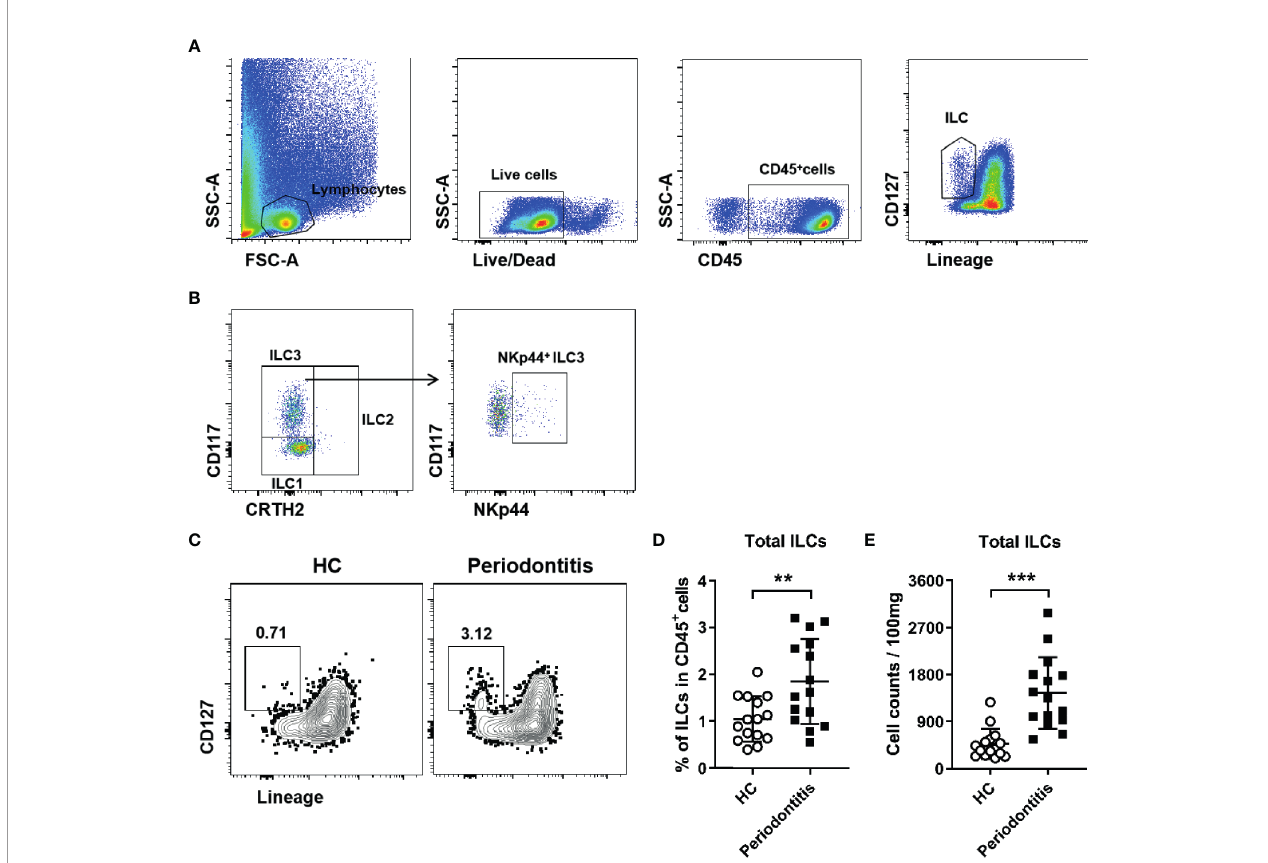
FIGURE 1 | Increased ILCs in periodontal ligament tissue from periodontitis patients. (A) Gating strategy for total ILCs in human periodontal ligament tissue. Lineage markers include CD3, CD19, CD94, CD14, CD16, CD1a, CD303, CD123, Fc ϵ R1 a , and CD34. (B) Gating strategy for ILCs subsets in human periodontal ligament tissue. (C) Representative fl ow cytometry analysis of total ILCs in periodontal ligament tissue from healthy individuals (left) and periodontitis patients (right). (D) Frequency (in CD45 + immune cells) and (E) absolute cell numbers (per 100 mg tissue) of total ILCs in periodontal ligament tissue from healthy controls and periodontitis patients. n = 15 for each group. **p < 0.01, ***p <